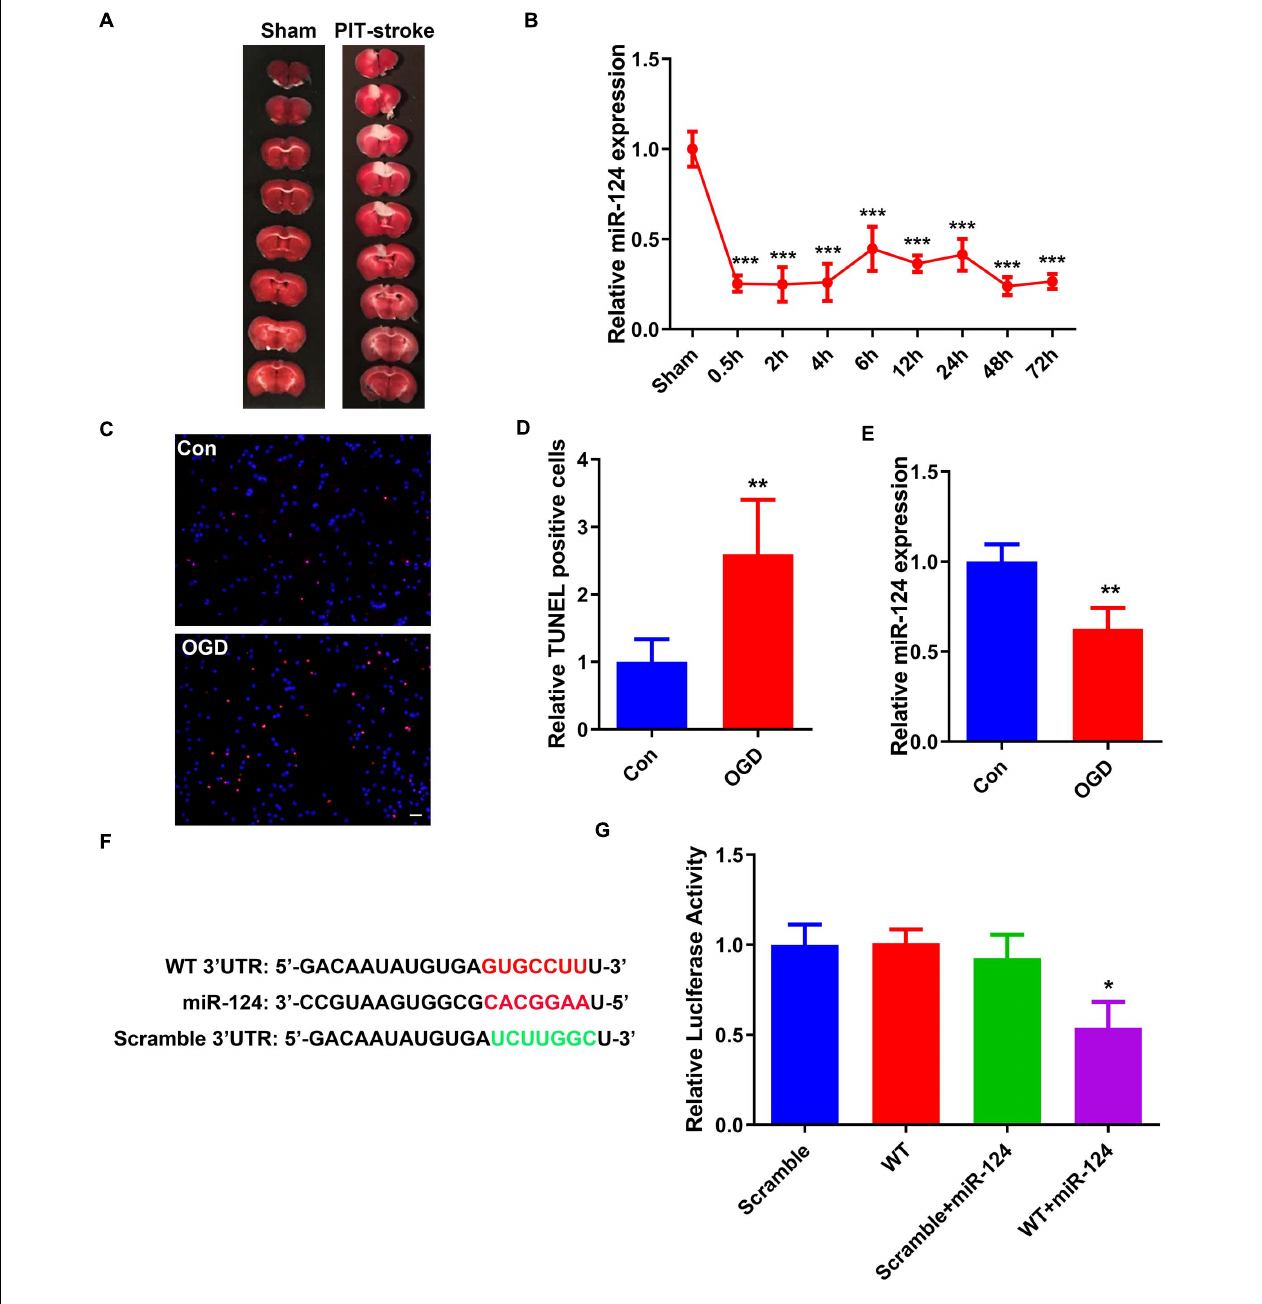
FIGURE 1 | PIT-stroke induced decreased levels of miR-124 and increased DAPK1 levels. (A) Representative graph of 2,3,5-triphenyltetrazolium chloride (TTC) staining showing cerebral infarct in PIT-stroke. (B) Changes in miR-124 expression levels at 0.5, 2, 4, 6, 12, 24, 48, and 72 h after PIT-stroke ( n = 3/group). (C) TdT-mediated dUTP nick end labeling (TUNEL) staining (red) in primary cultured neurons [14 days in vitro (DIV)] was performed after an oxygen glucose deprivation (OGD) challenge (scale bar = 50 µ m) and quantified (D) ( n = 4/group). (E) Bar graph shows the relative expression of miR-124 following OGD. (F) Predicted binding sites of miR-124 in DAPK1 3 (cid:48) -UTR and its mutant. (G) Human embryonic kidney 293 (HEK293) cells were co-transfected with miR-124 or control miRNA with wild-type (WT) or mutated (scrambled) 3 (cid:48) -UTR of DAPK1. Data are presented as mean ± SD ( n = 6/group). * p < 0.05, ** p < 0.01, *** p < 0.001 vs. Sham or Con or scramble